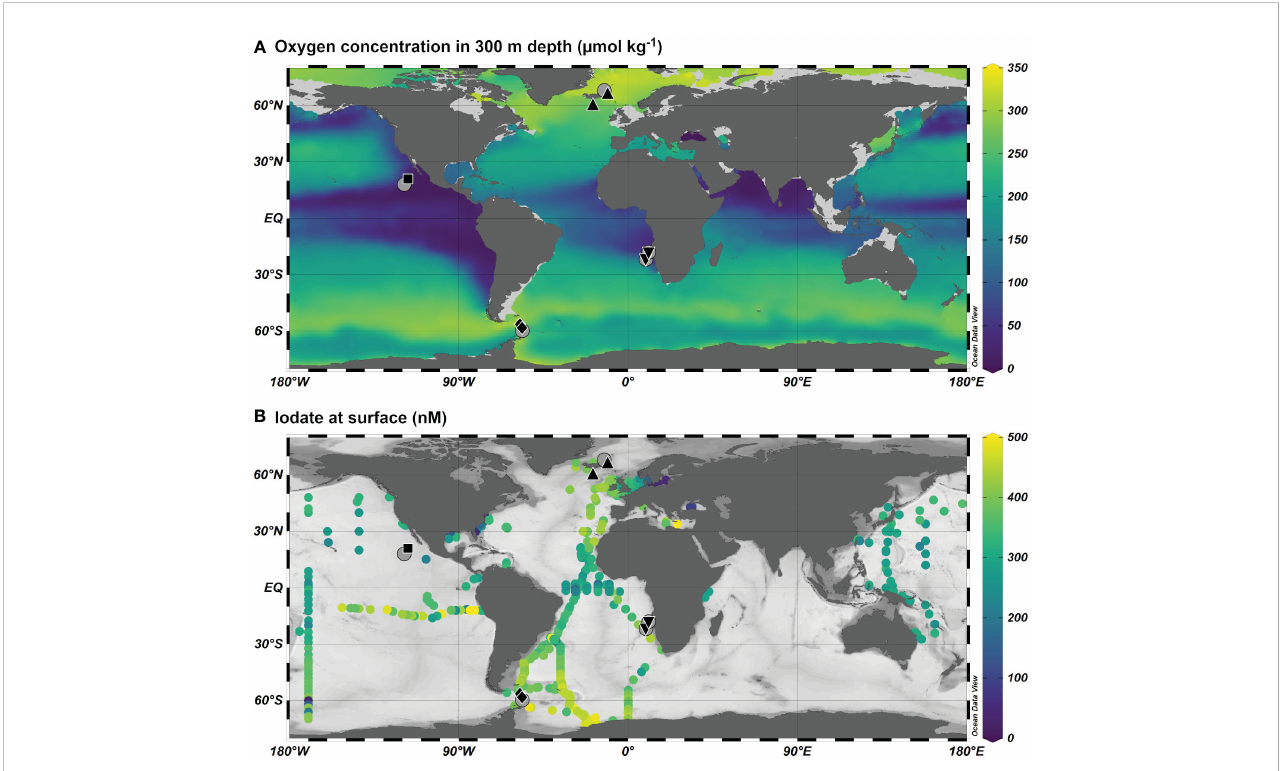
FIGURE 1 Station map for plankton tows (black, see Table 1) and iodate pro fi les (grey circles) from Moriyasu et al. (2020) in the Paci fi c, Bluhm et al. (2011) in the Southern Ocean, Waite et al. (2006) in the North Atlantic and from this study in the Benguela Upwelling System. (A) Average oxygen concentration at 300 m from the World Ocean Atlas 2018 (Garcia et al., 2019). (B) Iodate concentration at the surface (< 15 m) from the compilation described in Chance et al. (2014), plus Cutter et al. (2018) and Moriyasu et al. (2020) (dataset available: https://www.bco-dmo.org/dataset/776552). Plotted using Ocean Data View (Schlitzer,